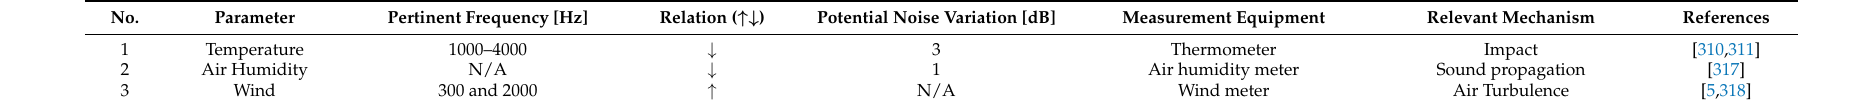
Table 19. Summary of environmental parameters affecting